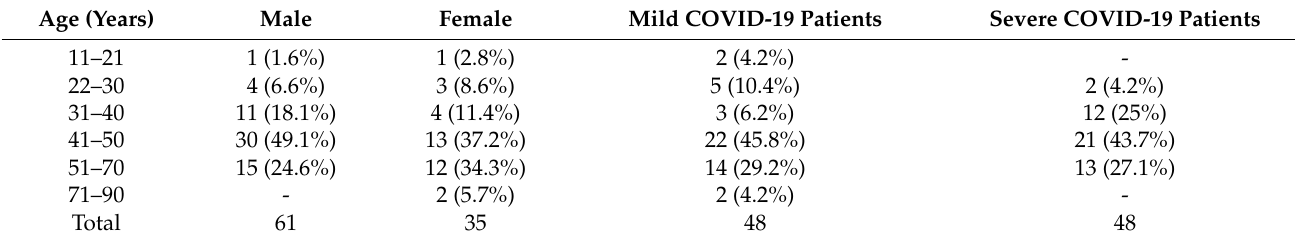
Table 1. Brazilian COVID-19 patients group stratification by age and clinical outcomes.